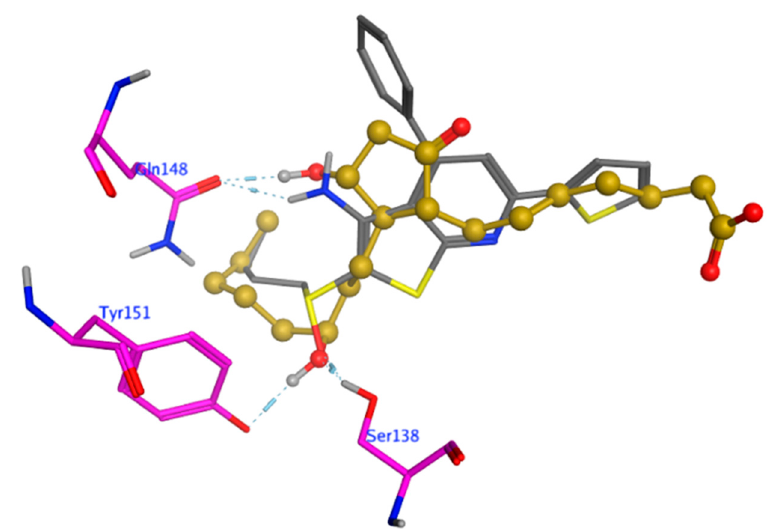
Figure 5. Overlay of the docked pose of ( R )-S(O)-SW033291 (colored grey) vs. PGE2 (colored yellow) reveals differences between ( R )-S(O)-SW033291 and